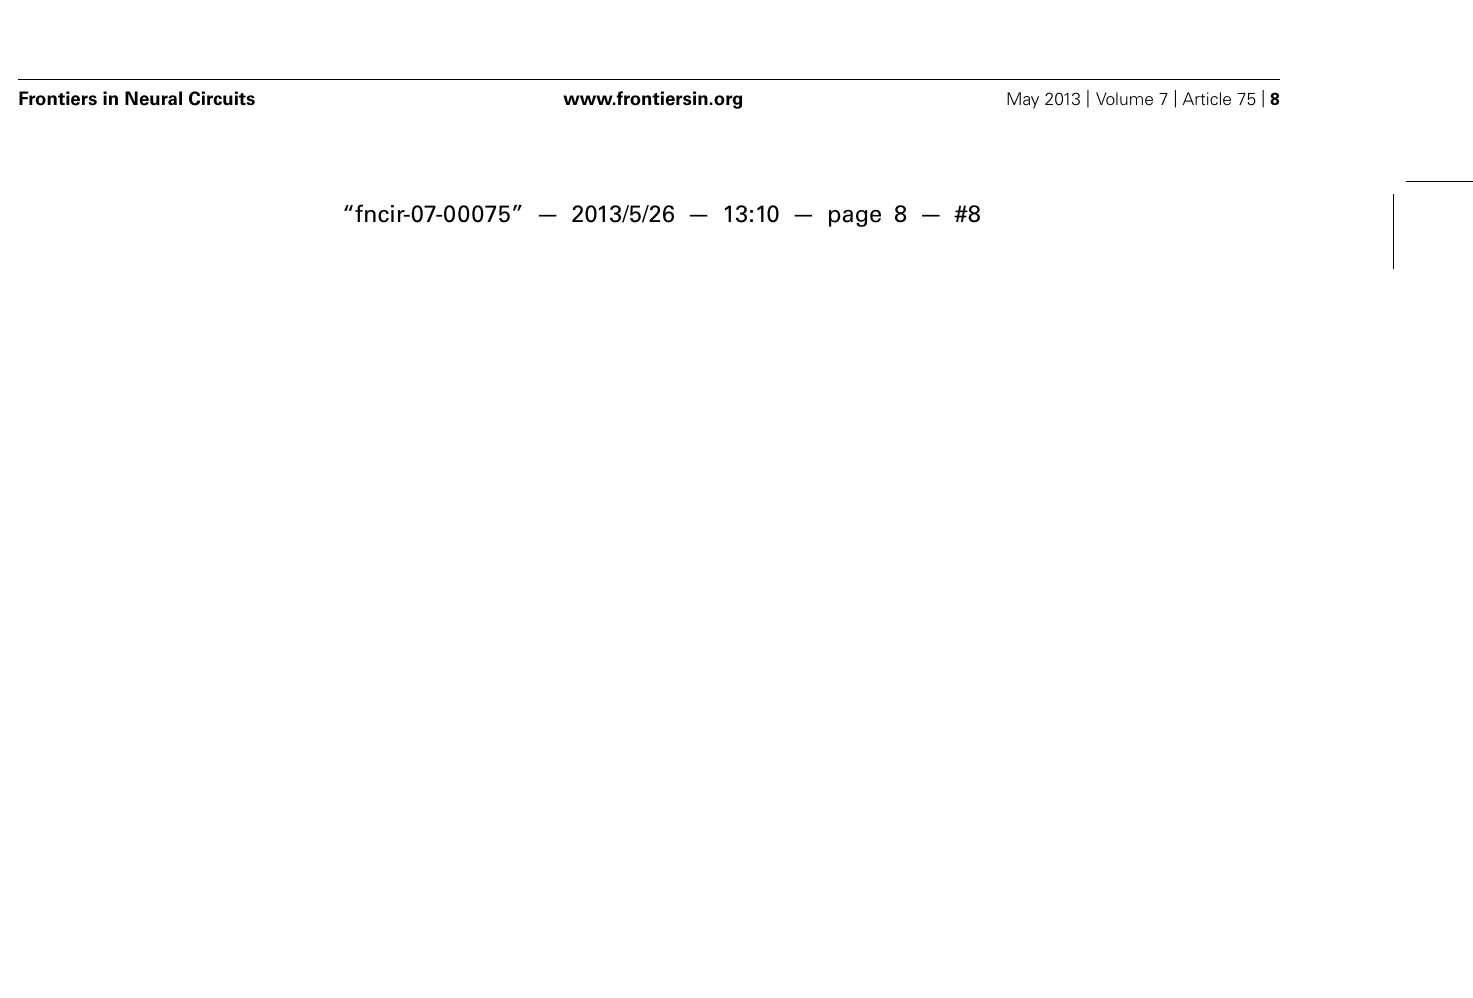
neurons were different in electrical properties: L2/3 pyramidal neurons showed regular-spiking responses with slow adaptation (B) , whereas L3d/L4 star-pyramidal neurons exhibited regular-spiking ones with fast adaptation (D) , when a long depolarizing current pulse was injected. Modified with permission from Figures 2–4 of Cho etal. (2004b) and Figures 4 and 5 of Cho etal.